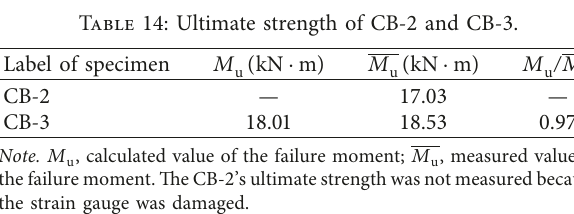
the strain gauge was